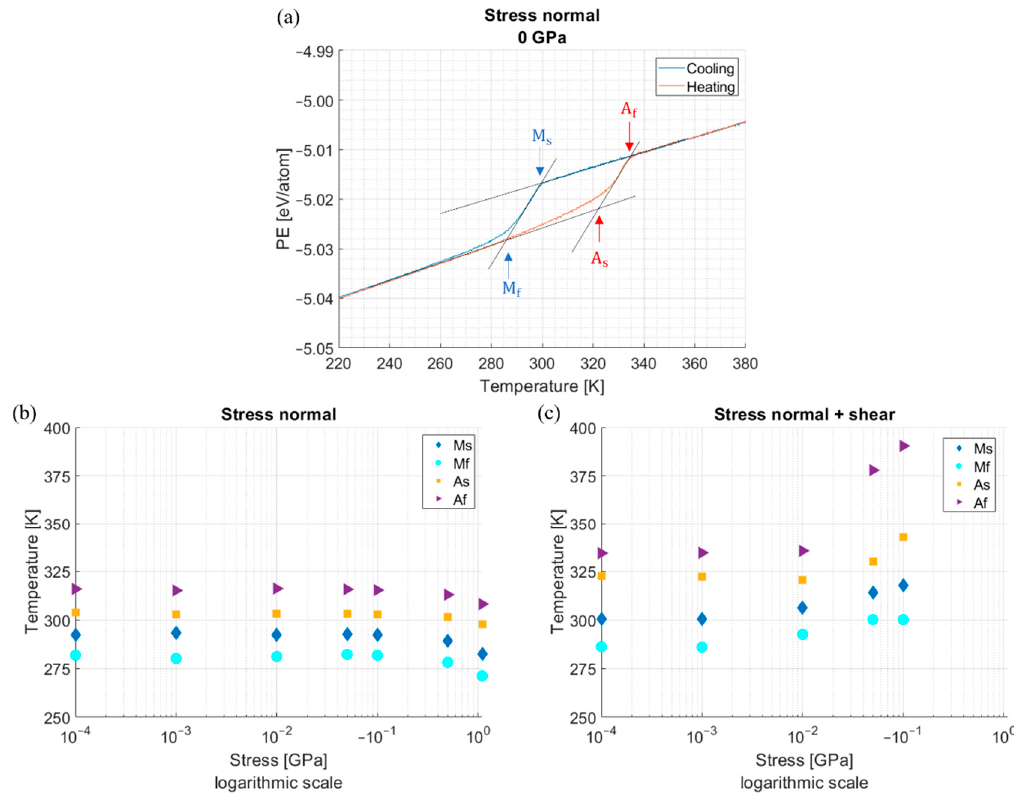
Figure 4. Phase transformation temperatures obtained from simulation domains. ( a ) Phase transformation temperatures obtained from PE profile; ( b ) stress applied in normal directions; ( c ) stress applied in both normal and shear directions.